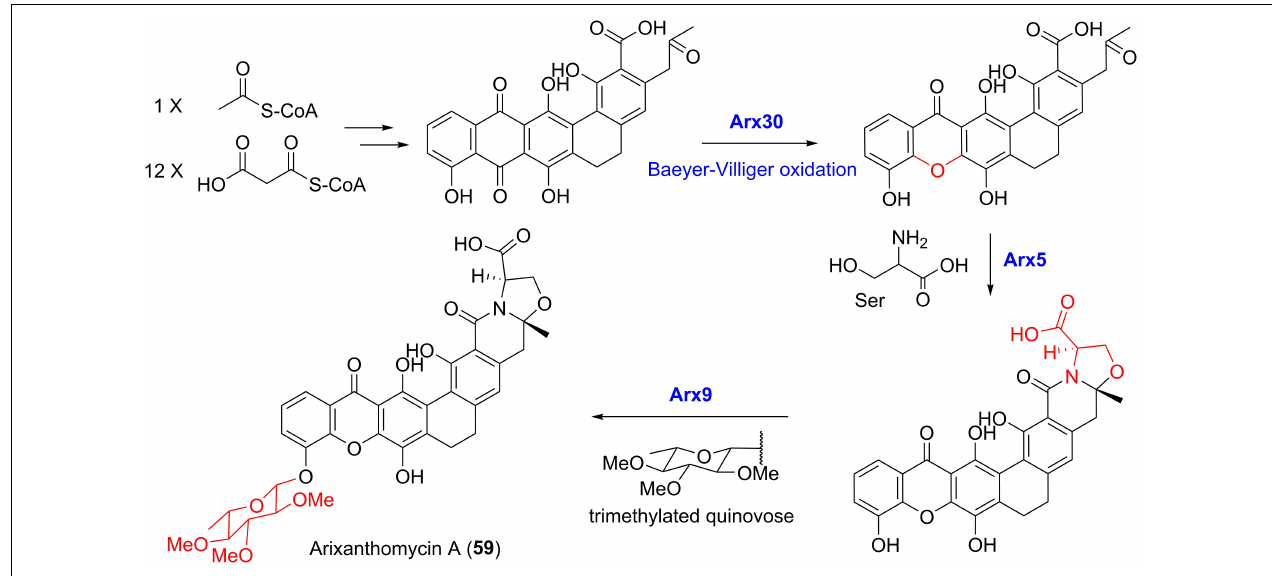
FIGURE 10 | The proposed biosynthetic pathway of arixanthomycin A ( 59